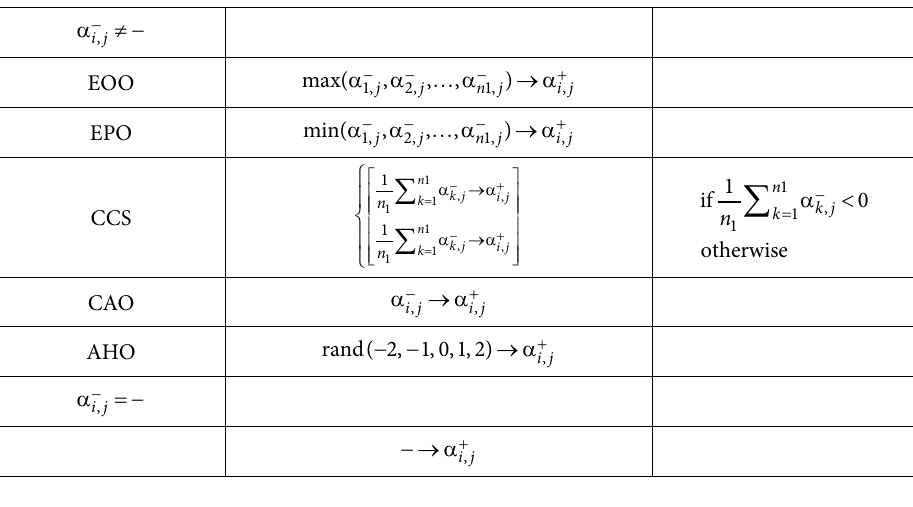
Table 1. The main QAD operators